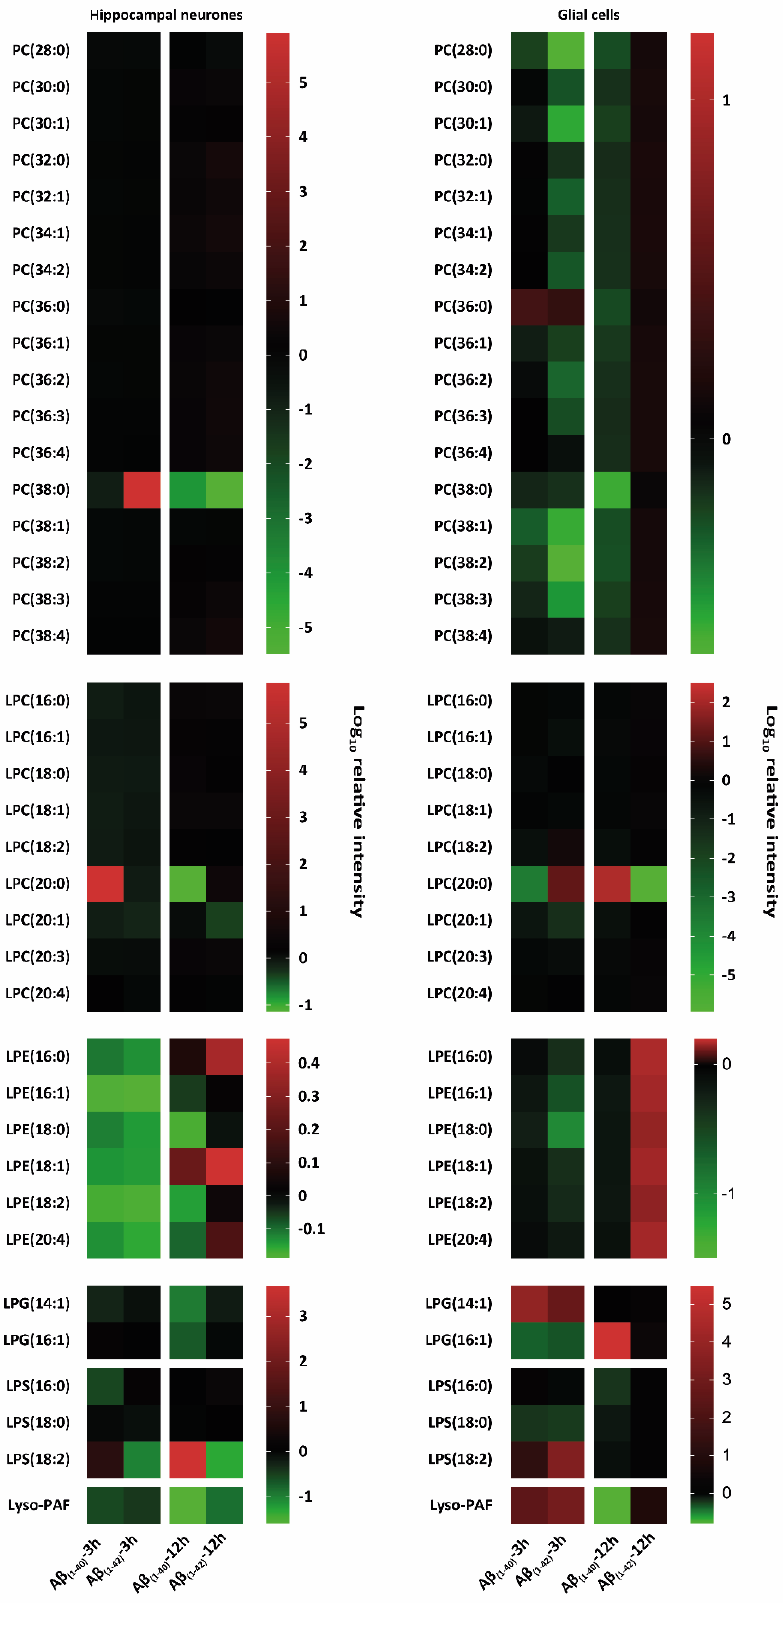
Figure 4. Heat map-based mass spectrometry analysis of glycerophospholipid classes from hippocampal neurones and glial cells after 3 h and 12 h A β treatment. Here, we examined